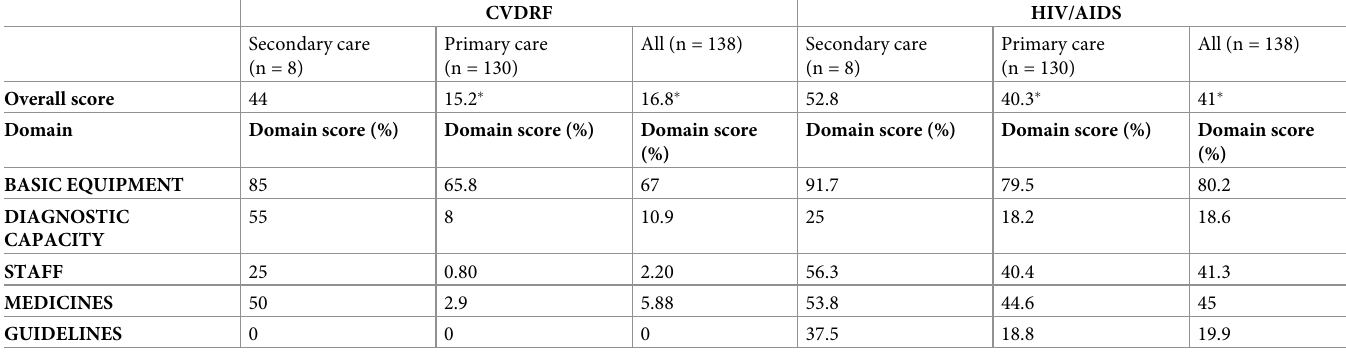
Table 5. Summary readiness scores for cardiovascular disease and cardiovascular disease risk factors (CVDRF) and HIV/AIDS for selected secondary and primary care facilities in Bo, Sierra Leone–see S1 File for components in each